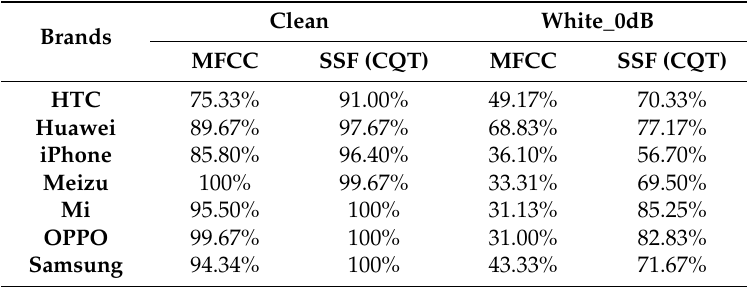
Table 4. Classification results of MFCC and SSF (CQT) for different brands.